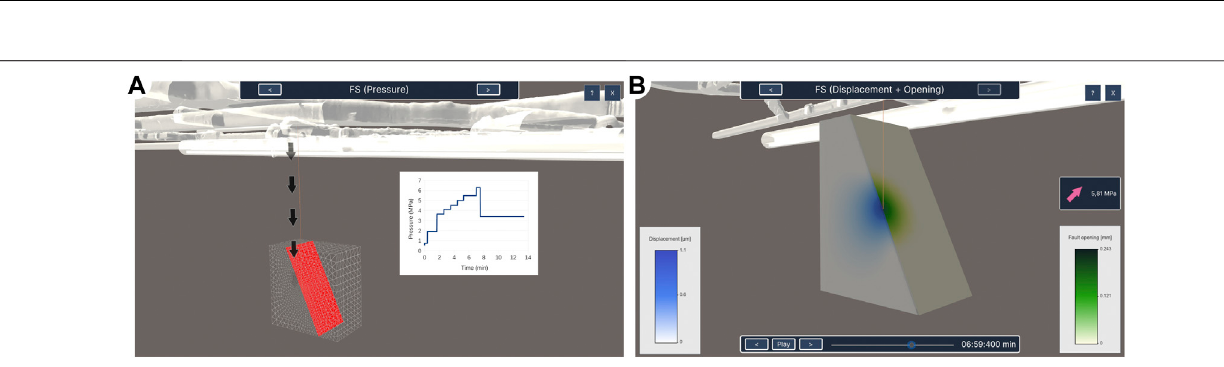
Frontiers in Earth Science |